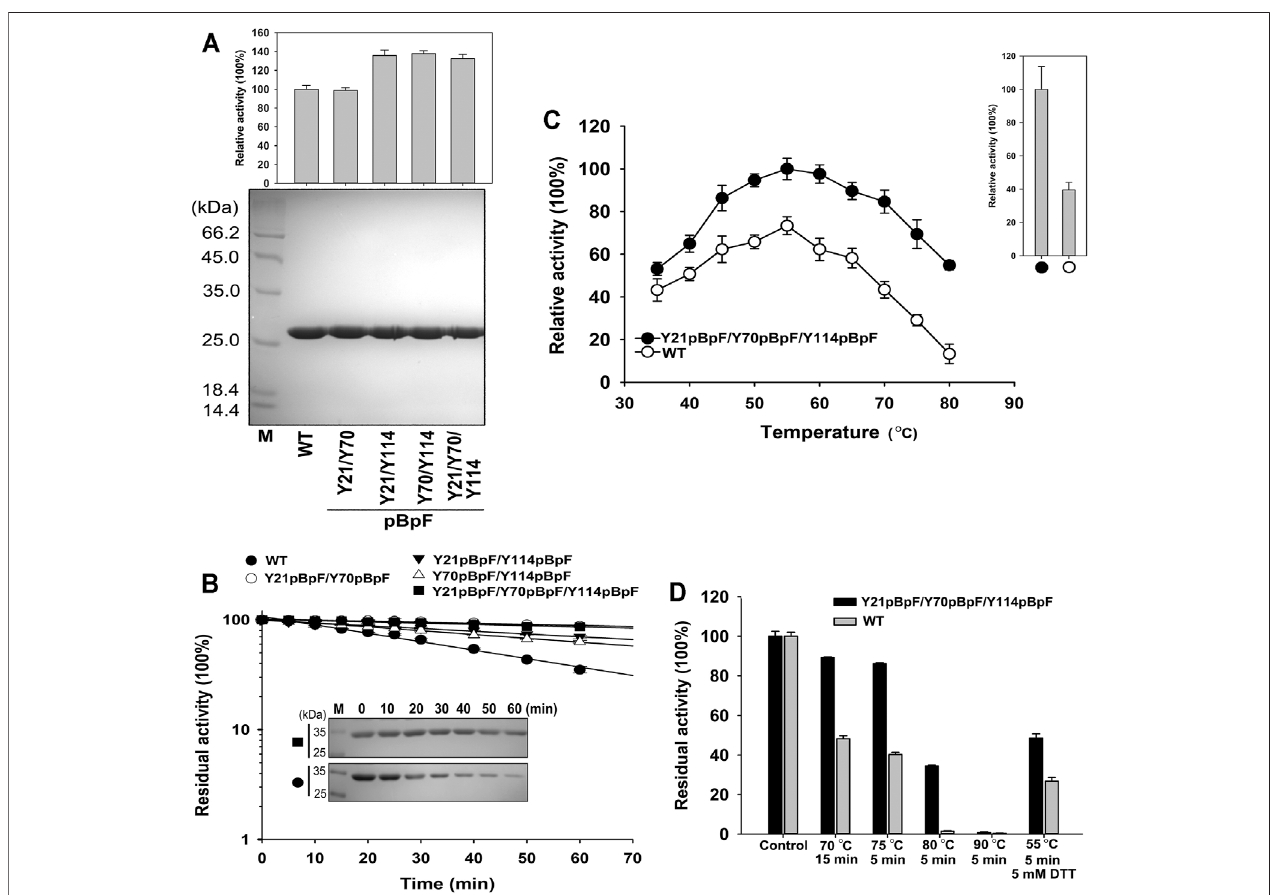
FIGURE 6 | Properties of Y21pBpF/Y70pBpF/Y114pBpF variant. (A) Activity assays ( upper ) and SDS-PAGE analysis ( lower ) of puri fi ed samples of wild-type (WT) anditsvariants.Azocaseinolyticactivitywasassayedat55 ° CinPhosphateBuffer(PB). (B) Heatinactivationpro fi lesofvariants.Enzymesampleswereincubatedat65 ° C forindicatedtimes,andassayedforresidualactivityusingazocaseinassubstrateat55 ° CandSDS-PAGEanalysis( insetpanel ). (C) ActivityanalysisofWTanditsvariant at different temperatures. Enzyme samples were incubated with 2.5 g/L azocasein in PB at various temperatures for 10 min. Activity at optimal temperature of variant(55 ° C)wasde fi nedas100%.UpperrightpaneldepictsrelativeactivityofWTanditsvariantinpresenceof5 mMDL-dithiothreitol. (D) ThermostabilitiesofWTand its variant. Enzyme samples were incubated at different temperatures for indicated times, followed by azocaseinolytic activity assay. Values are means ± Standard Deviation (SD) of three independent experiments.